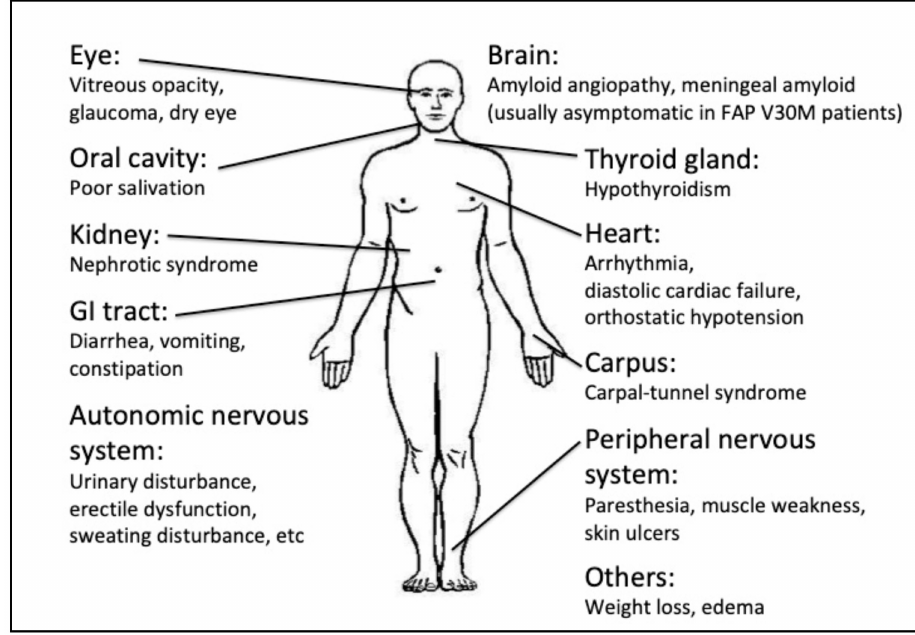
Figure 1. Clinical manifestations in ATTRv patients. Modified from: Recent advances in transthyretin amyloidosis therapy, Mitsuharu Ueda and Yukio Ando [8].